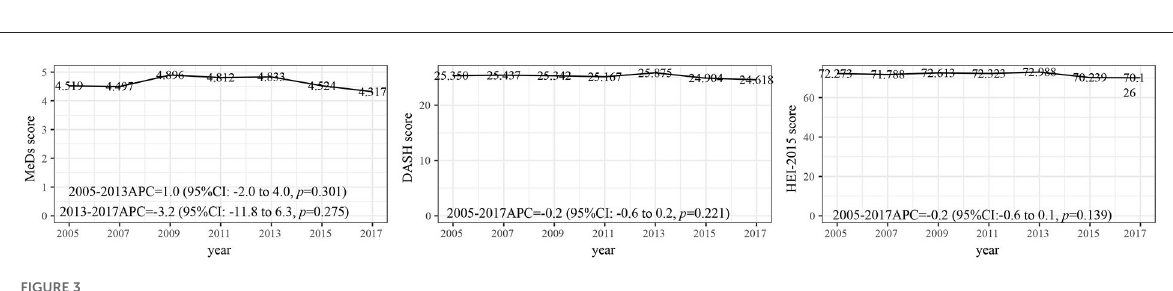
depression in patients with only 1 cancer (OR: 0.90, 95% CI: 0.82–0.98, p = 0.019; Table